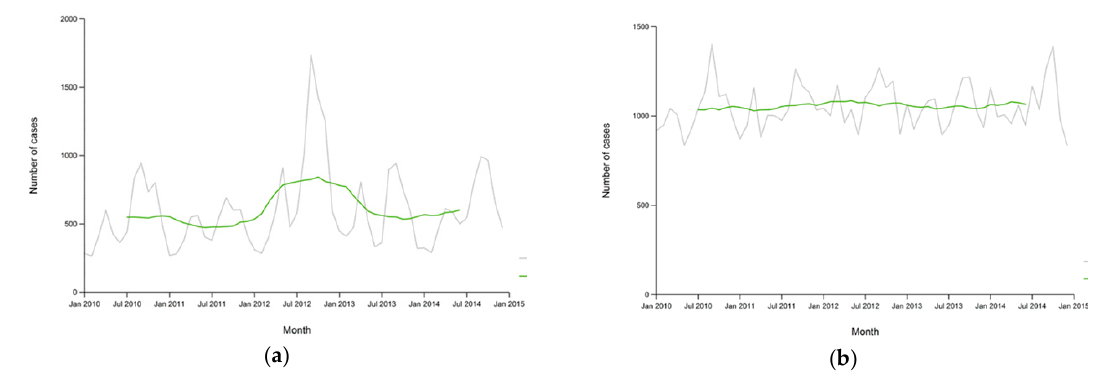
Figure 5. ECDC 2010–2015 European monthly total reported confirmed cases per 100,000 population with 12-month moving average (green) of ( a ) cryptosporidiosis [25]; ( b ) giardiasis